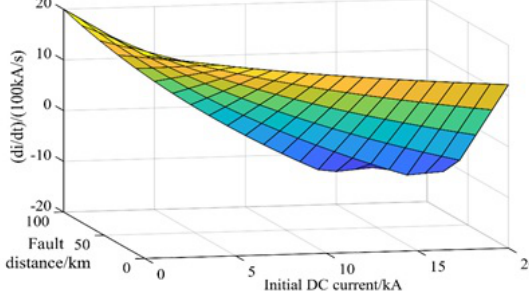
Fig. 7. Influences of the fault distance and initial DC on the di/dt.